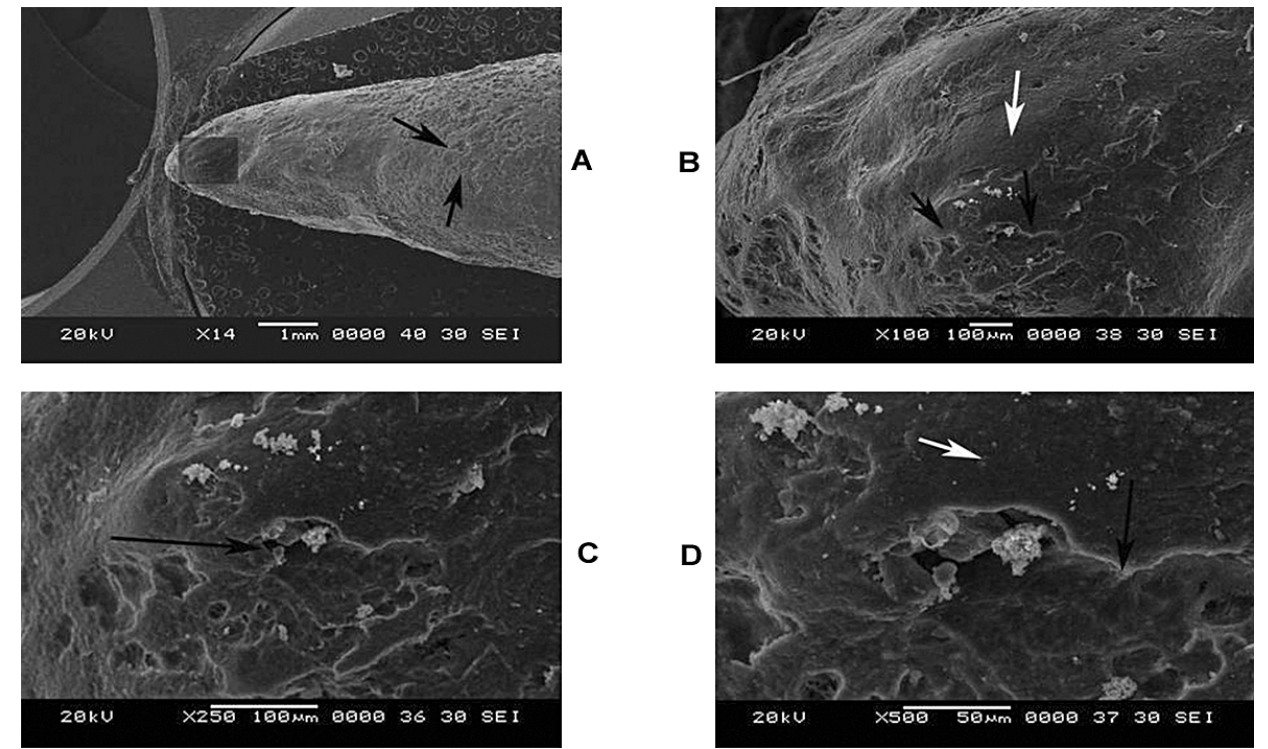
FIGURE 3 (A-D) - Root resorption of a premolar subjected to orthodontic force at 14x, 100x, 250x, 500 magnifications